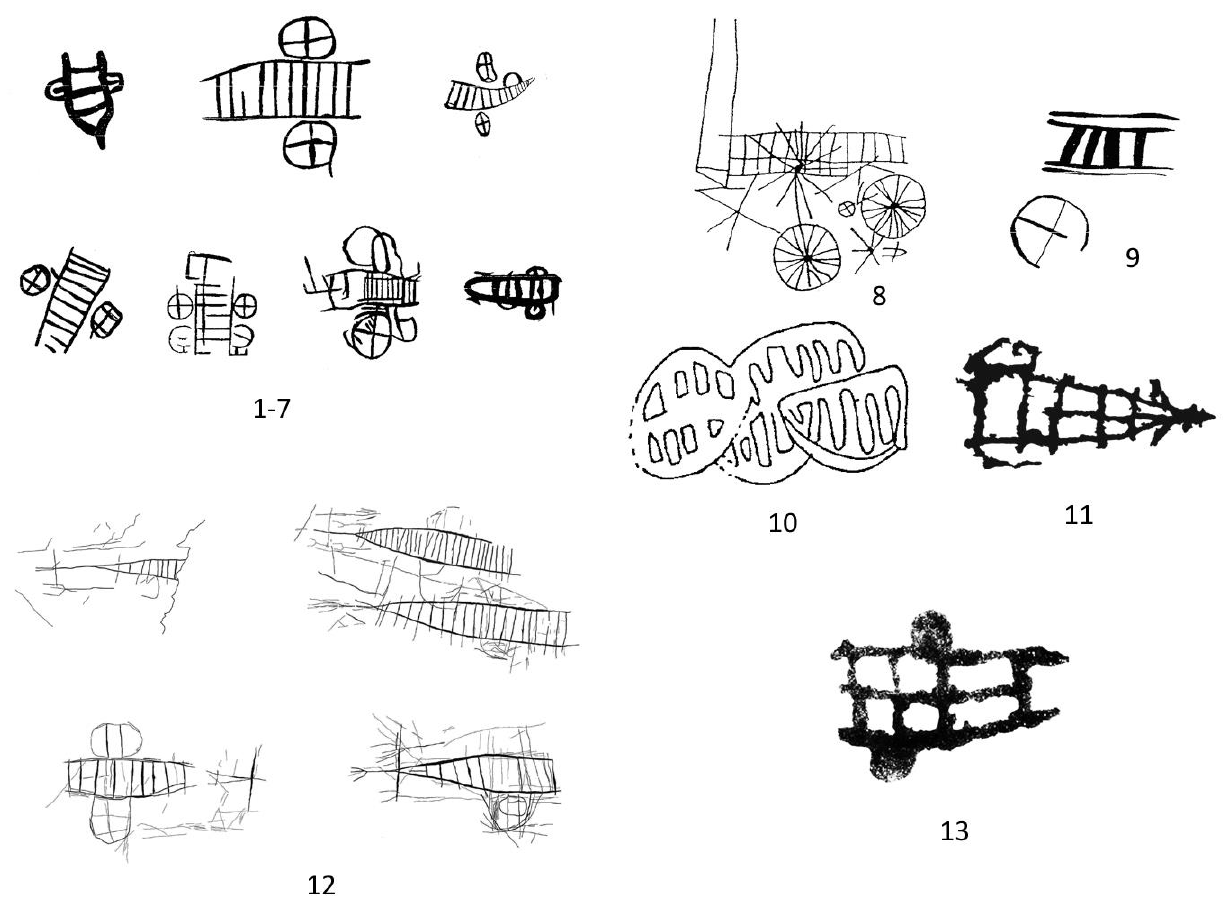
Figure 8. “chariots” in Extremadura rock art: 1–7 (Shelter V and X from Los Buitres Peñalsordo, taken from Bécares, 1994); 8 (Vegas de Coria, taken from Sevillano, 1991); 9 (Shelter of San Juan, San Serván, taken from León y García-Verdugo, 1983); 10 (Sierrapino, Hornachos, taken from Collado, 2000); 11 (Molino Manzánez, Alconchel-Cheles, taken from Collado, 2006); 12 (Roca de los Carros, Campanario); 13 (El Covacho, Oliva de